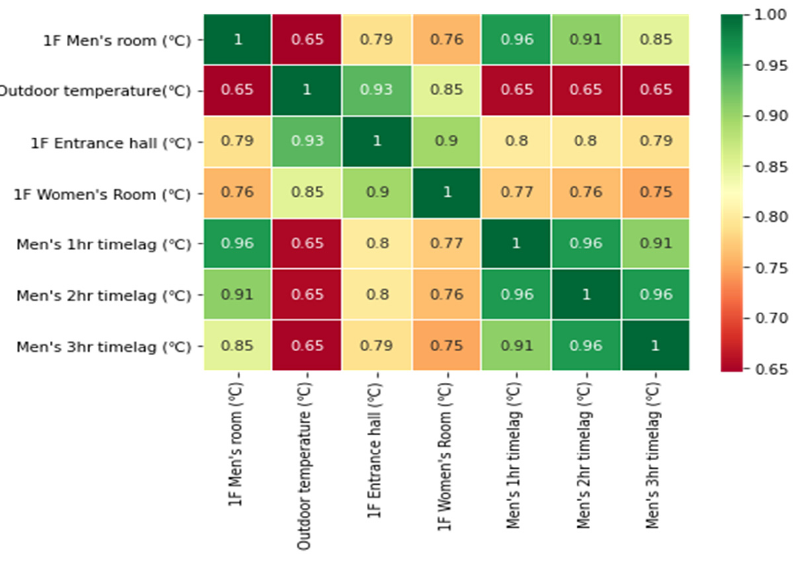
Figure 5. Correlation matrix with time lags for the selected optimal input features.